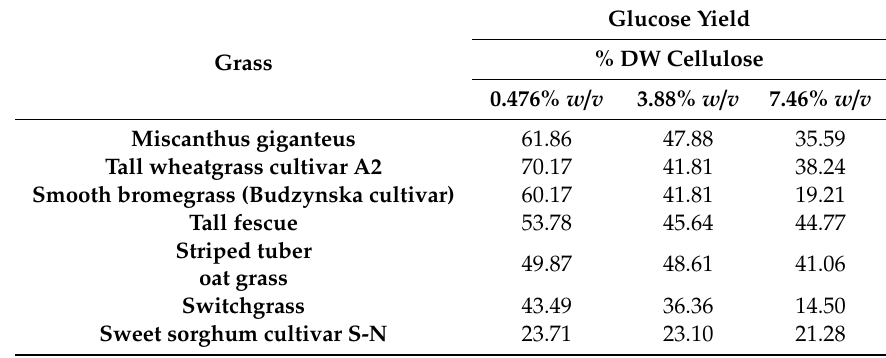
Table 7. Cellulose-to-glucose yields from the grasses at 3 concentrations of kraft pulps (0.476, 3.88